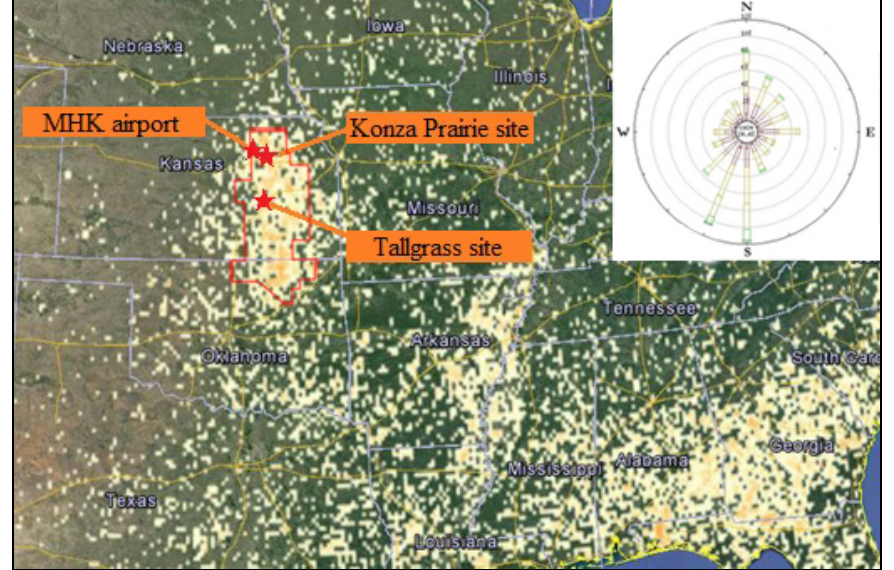
Figure 1. Map showing National Oceanic and Atmospheric Administration (NOAA) satellite image of Kansas Flint Hills burning activities in 2014 and location of the Konza Prairie and the Tallgrass sampling site (the approximate perimeter of the Flint Hills region is indicated in red lines; the wind rose is from the weather station at MHK airport).